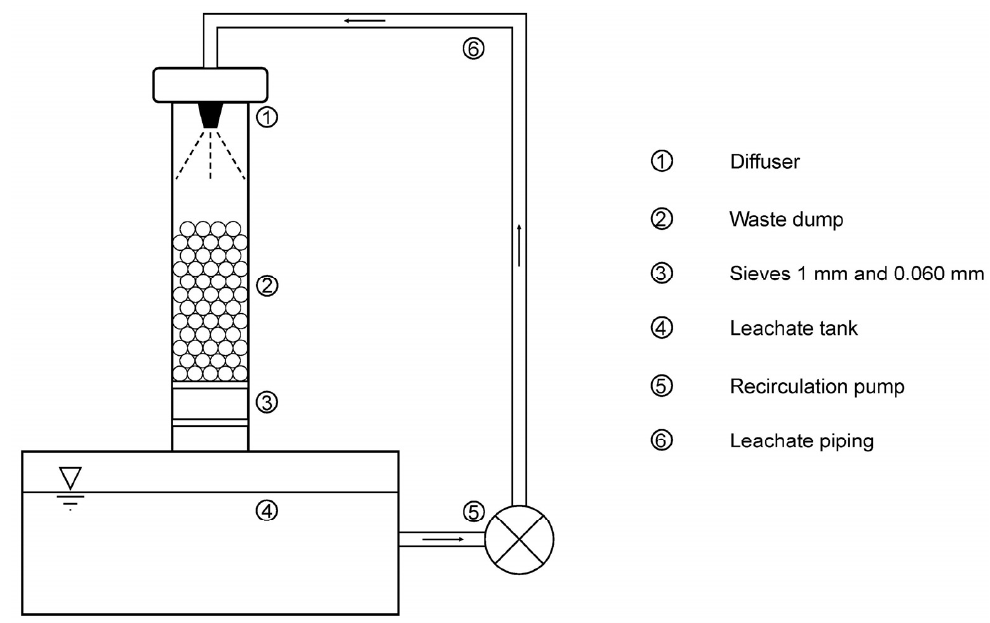
Figure 2. Leachate equipment for leaching of mining waste in acidic media, ambient temperature, and atmospheric pressure.